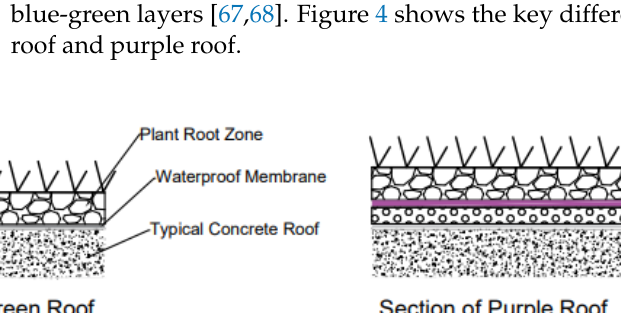
Figure 4. Typical Sections of a Green Roof and Purple Roof .